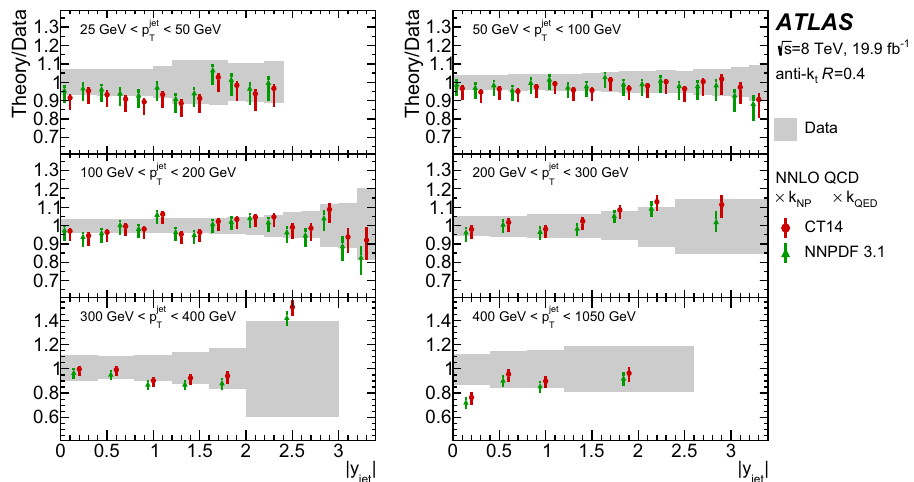
Fig. 16 Ratio of the measured Z + jets production cross-section and the NNLO QCD predictions, obtained using NNLOJET, corrected for thenon-perturbativeandQEDradiationeffectsasafunctionof | y jet | and p jet bins. Theoretical predictions are calculated using various PDF sets. T The coloured error bars represent the sum in quadrature of the effects